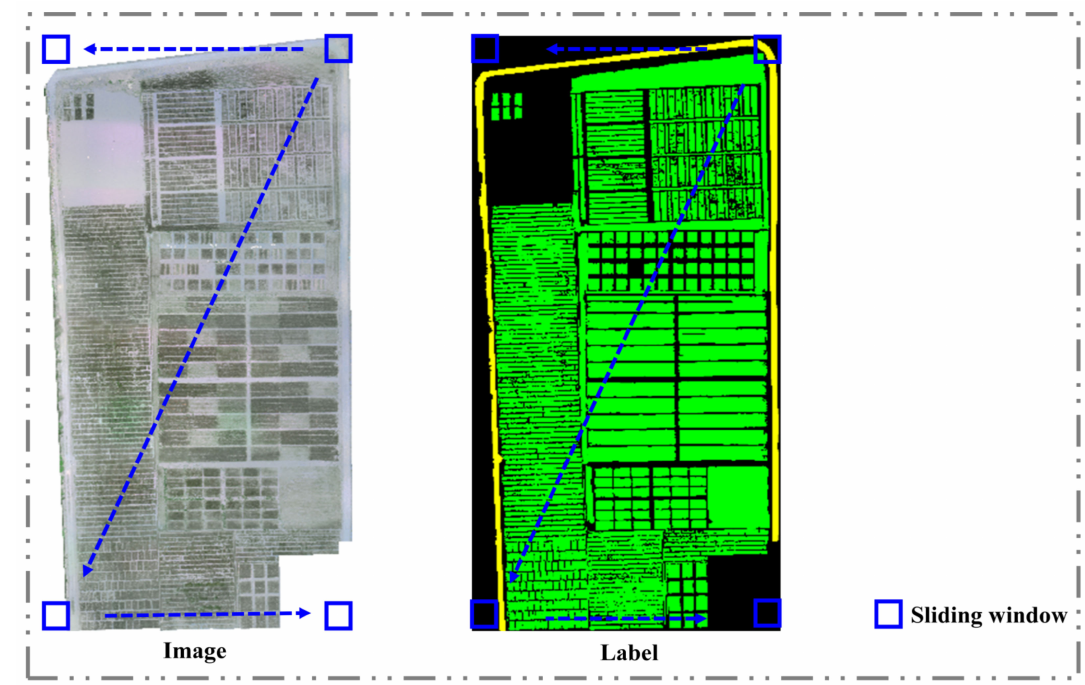
Figure 9. Cropping multispectral images and their labels.